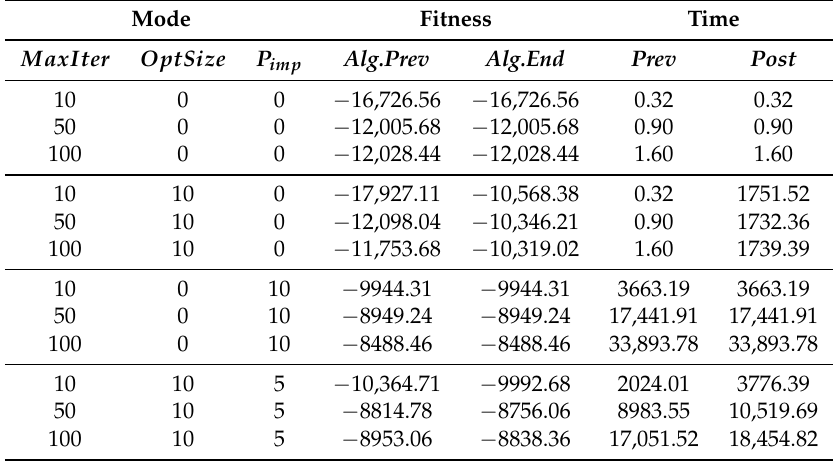
Table 1. Average fitness and run time (over 10 simulation runs) for different parameters configuration of the hybrid